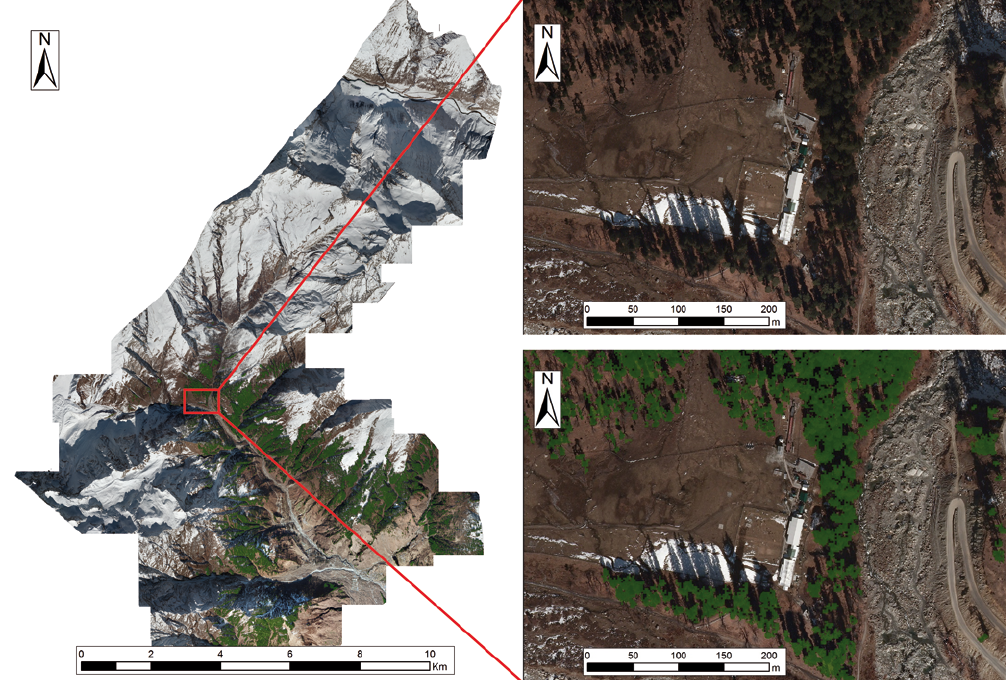
Fig. 5. (a) Results obtained for automated forest classification for the entire investigation area using supervised maximum likelihood clas- sification with NDVI as input, (b) subset of the Dhundi Meteorological Observatory (top) and final pine tree patch classification in green